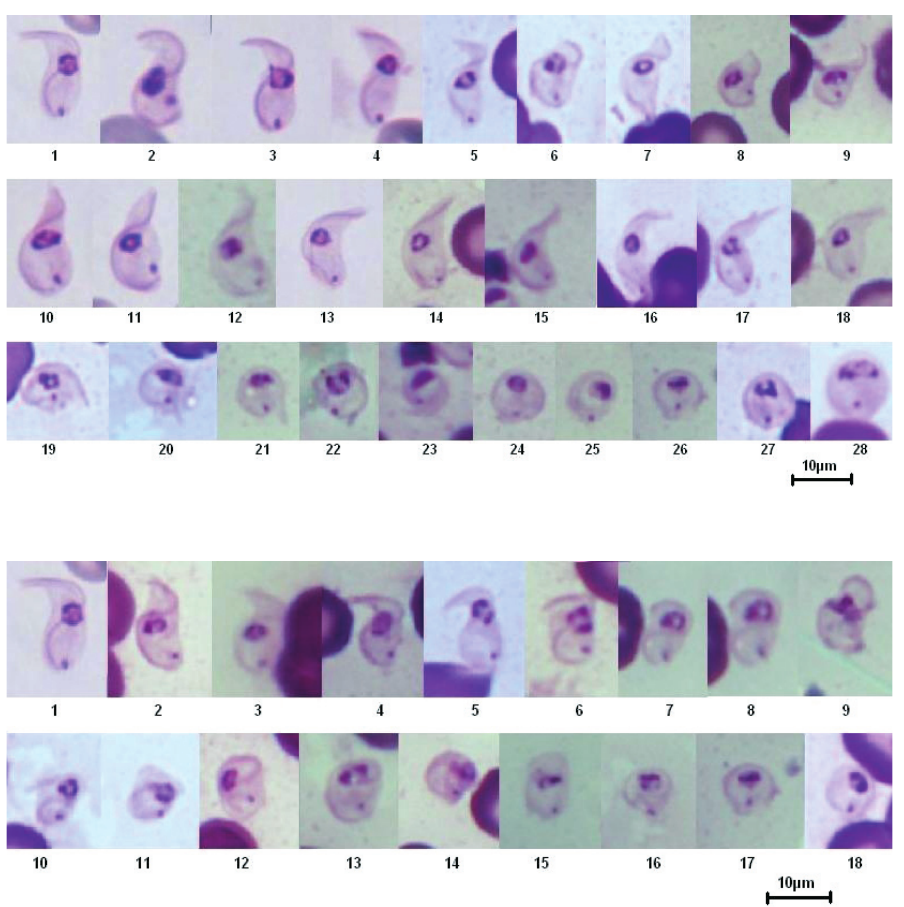
Fig. 13. – Tentative serial “C- shape” transformation of the T. (Nannomonas) hyperpachy- morph into sphaeromorph (unfol- ding and “C-folding” model). Photo by Marc Desquesnes.